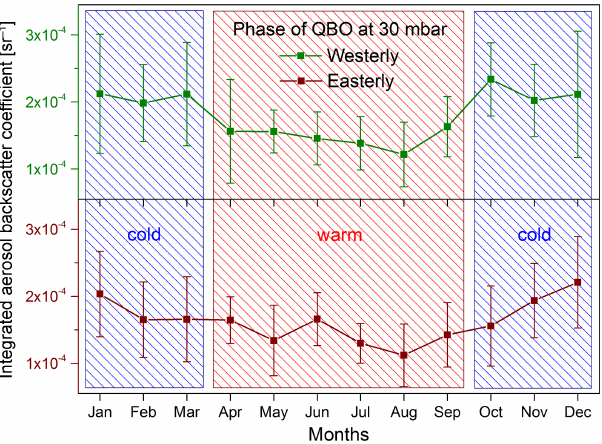
Figure 3. Intra-annual variation of the background monthly average of the SAL lidar B a π values averaged over 16 years (1999–2015) observations, excluding aftereffects of volcanic eruptions during the period. The B a π values were averaged separately for the westerly and easterly phases of the QBO characterized by zonal winds in the equatorial region at 30mbar. All error bars represent the standard